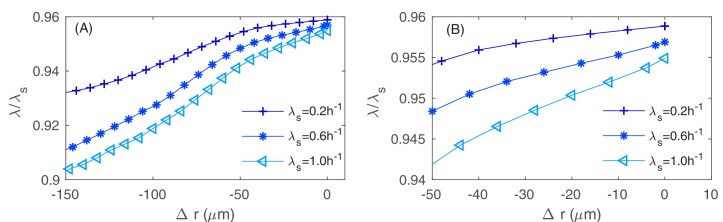
The azimuthally averaged and rescaled local growth rate λ/λS as function of the signed distance Δr to the colony rim with various values of the batch culture growth rate λS.Precise definition of this signed distance Δr is given in Equations (A1.5.1) in Appendix 1.5 on coarse-grained variables. At the rim Δr=0, the nutrient concentration C is close to Cs, the constant concentration value in the boundary condition, and λ/λS is close to Cs/(Cs+KS), which is 0.96 with our choice of parameters Cs=0.5mM and KS=0.02mM. (A) The average is taken over the entire colony, where the variation of the (rescaled) local growth rate is within 6%. (B) The average is taken over 1/3 of the colony near the rim, where the variation of the (rescaled) local growth rate is within 2%.